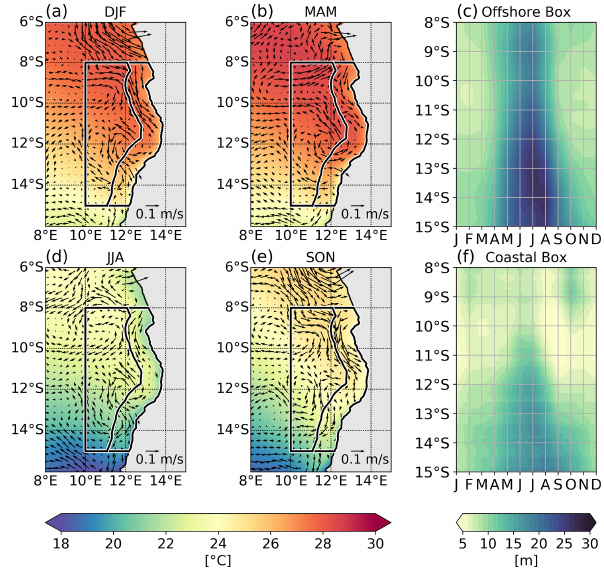
Figure 4. (a, b, d, e) Seasonal mean SST (colours) and surface ve- locities (arrows). The arrow length is referenced in the lower right corner of each panel. Black boxes show the coastal and offshore boxes used for calculating the ML heat budget. (c, f) Hovmöller plots of MLD as a function of latitude and month, zonally averaged over the (c) offshore and (f) coastal